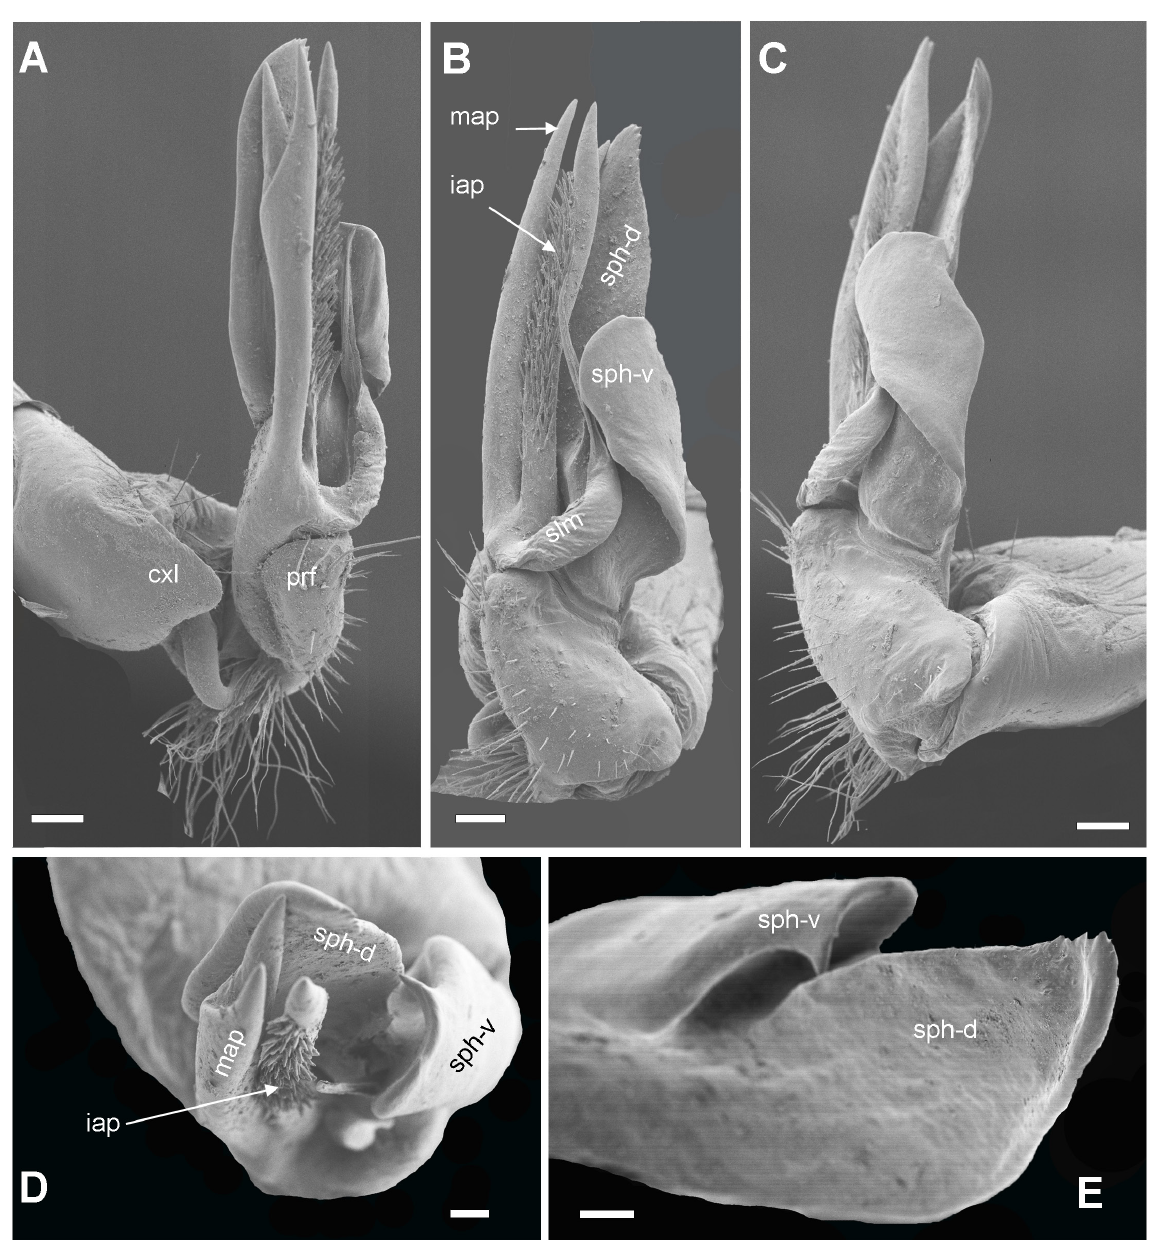
Fig. 10. Eviulisoma acaciae sp. nov., paratype, left gonopod. A . Mesal view. B . Ventral view. C . Lateral view. D . Acropodite, apical (anterior) view. E . Tip of solenophore, dorso-apical view. Abbreviations: cxl = coxal lobe; iap = intermediate acropodital process; map = mesal acropodital process; prf = prefemoral part; slm = solenomere; sph-d , sph-v = dorsal and ventral lobes of solenophore. Scale bars: A–C = 0.1 mm; D–E = 0.05